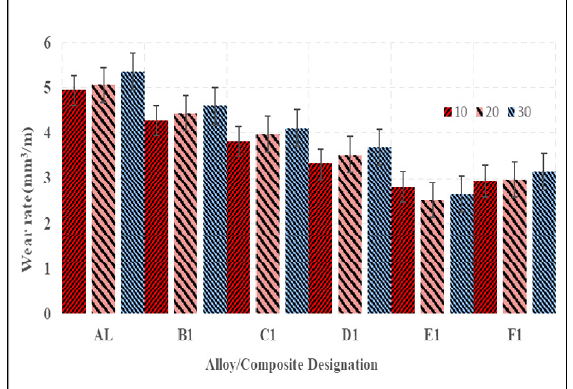
Figure 6. Wear rate of unreinforced and graphene/CNT reinforced aluminium hybrid composites for varying